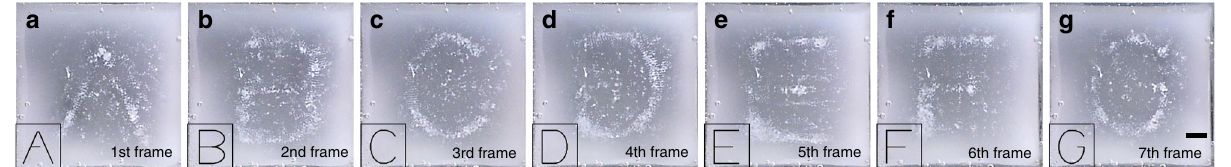
Fig. 5 Particle patterning using the spatial ultrasound modulator (SUM). a – g Multiple frames of particles patterned by the SUM acoustic fi eld in the form of the letters “ A ” to “ G ” . The scale bar is 1 mm. The dynamic process is shown in the Supplementary Movie